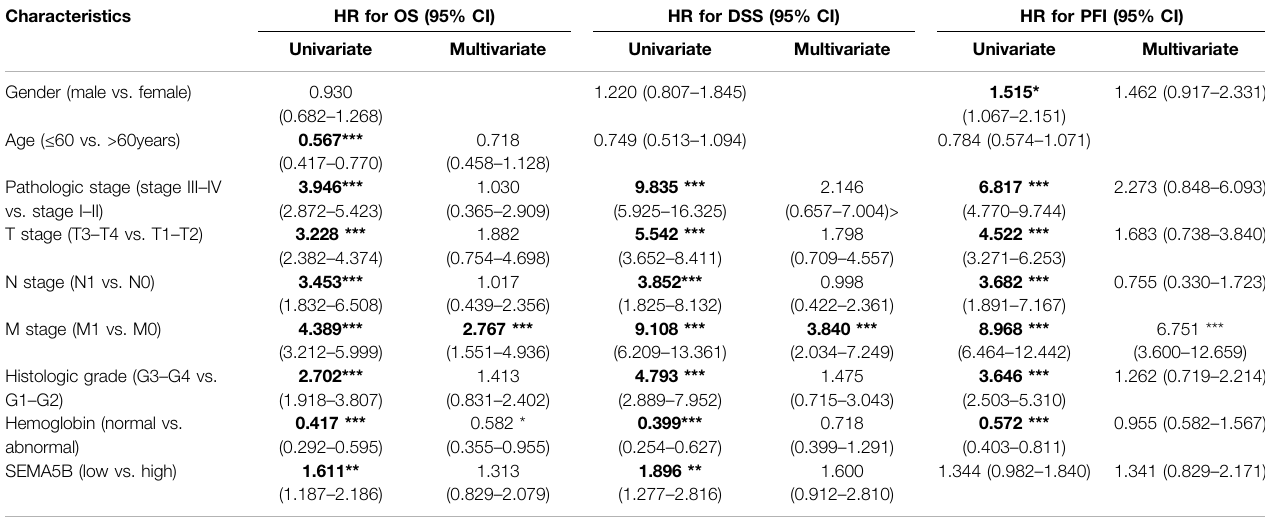
TABLE 2 | Cox regression analysis for clinical outcomes in KIRC patients.